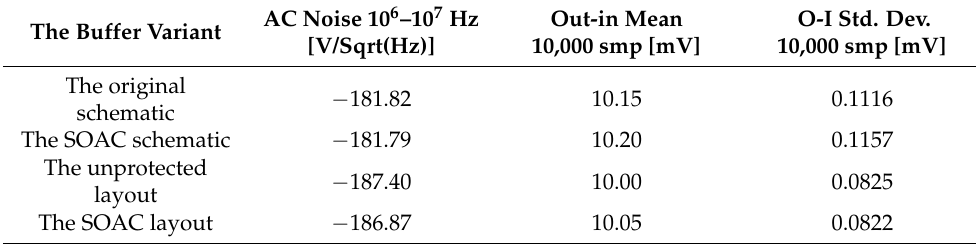
Figure 17. Results of the AC domain output noise simulations of all buffer variants; the original buffer—blue dotted line; the SOAC buffer-green dashed-dotted line; the laid-out original buffer— orange dashed line; the laid-out SOAC buffer-red solid line. Table 5. Comparison of the buffer noise properties for the selected implementation